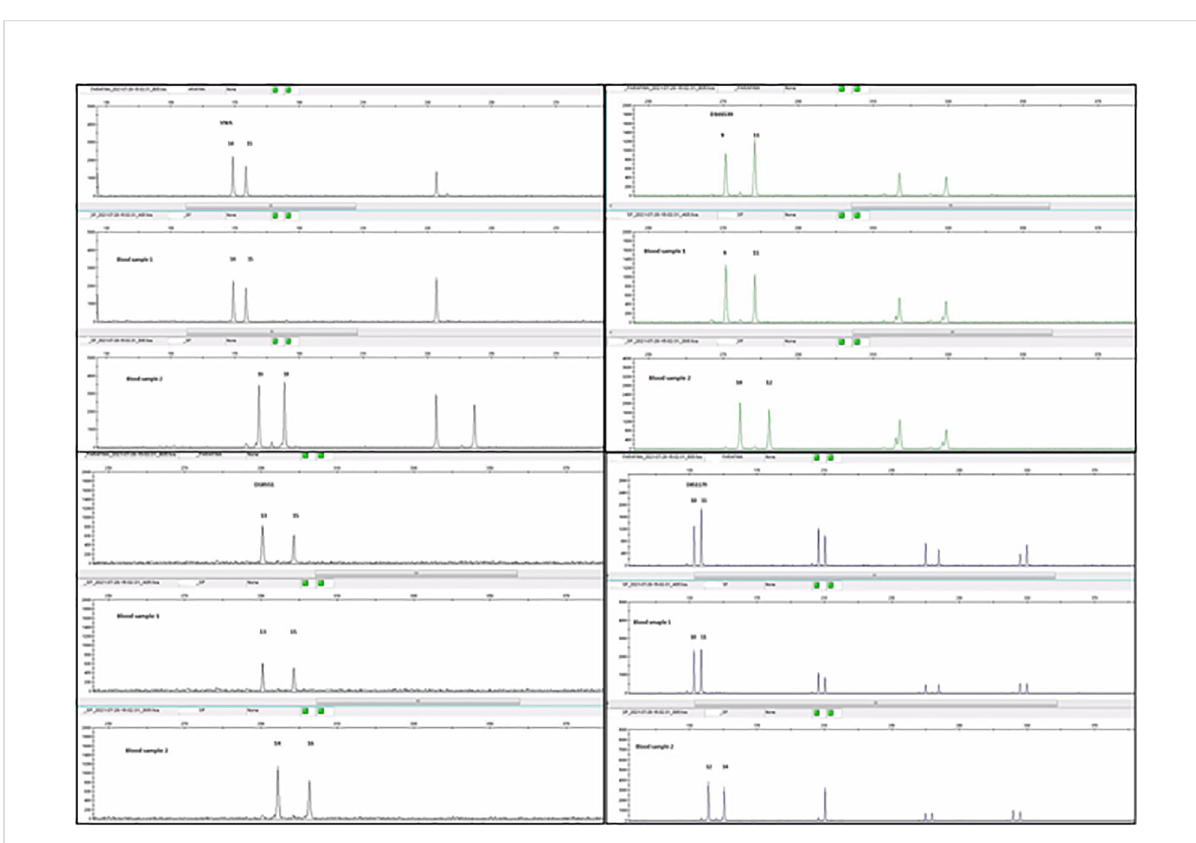
FIGURE 2 Comparative analysis of polymorphic markers (AmpFLSTR ™ Identi fi ler ™ Plus PCR Ampli fi cation Kit) in the tumor sample, patient (blood sample1) and partner (blood sample 2) blood samples. The pro fi le of tumor´s and patient´s DNA are coincident, with no contribution from the partner`s DNA (in the case of informative markers) (image courtesy of Margarida Reis-Lima, MD, Elsa Garcia, MSc, Nata ́ lia Salgueiro, MSc from Synlab laboratories, Porto,